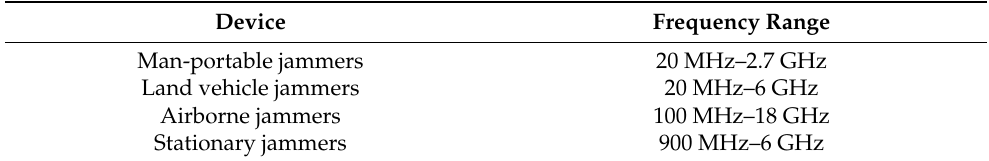
Table 4. Jammers and relative frequency